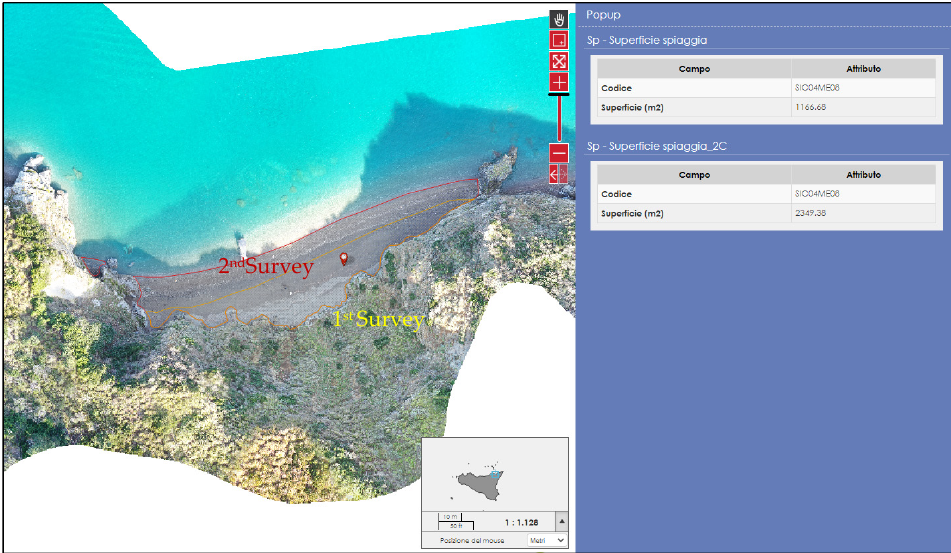
Figure 11. Example of comparison between beach surfaces of two successive surveys made in the PB of Tindari (Messina).